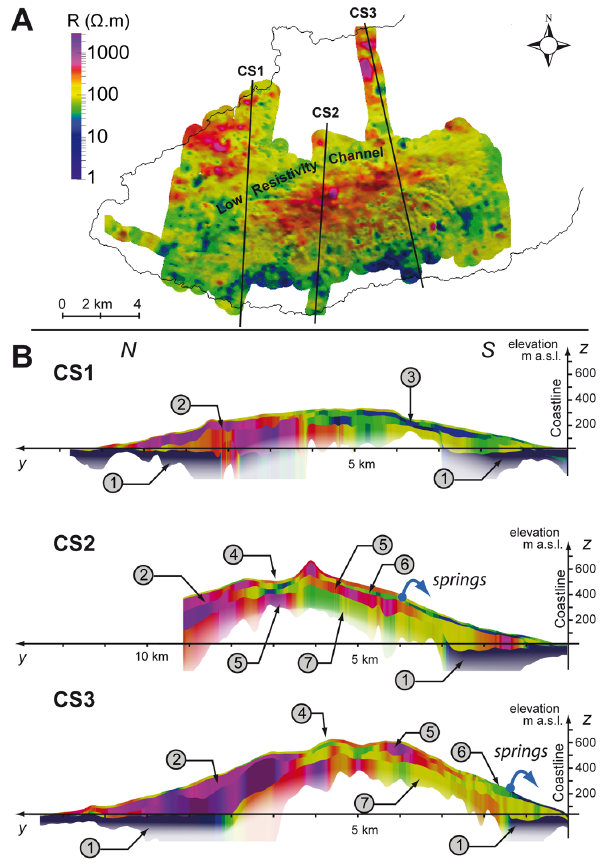
Fig. 4. (A) Surface resistivity of the 4-layer SkyTEM resistivity model. (B) Corresponding cross-sections. (1) Seawater intrusion ( < 15 (cid:127) m), (2) undifferentiated, unweathered, unsaturated volcanic rocks ( > 400 (cid:127) m), (3) very low resistivity unit (10–40 (cid:127) m) ex- panding from the summit area, (4) buried low resistivity chan- nel (30–100 (cid:127) m), (5) massive lava flows ( > 400 (cid:127) m), (6) perched aquifer (30–100 (cid:127) m) (7) Undifferentiated, unsaturated weathered basaltic rocks (100–400 (cid:127) m). The shading with depth reflects the approximative depth of